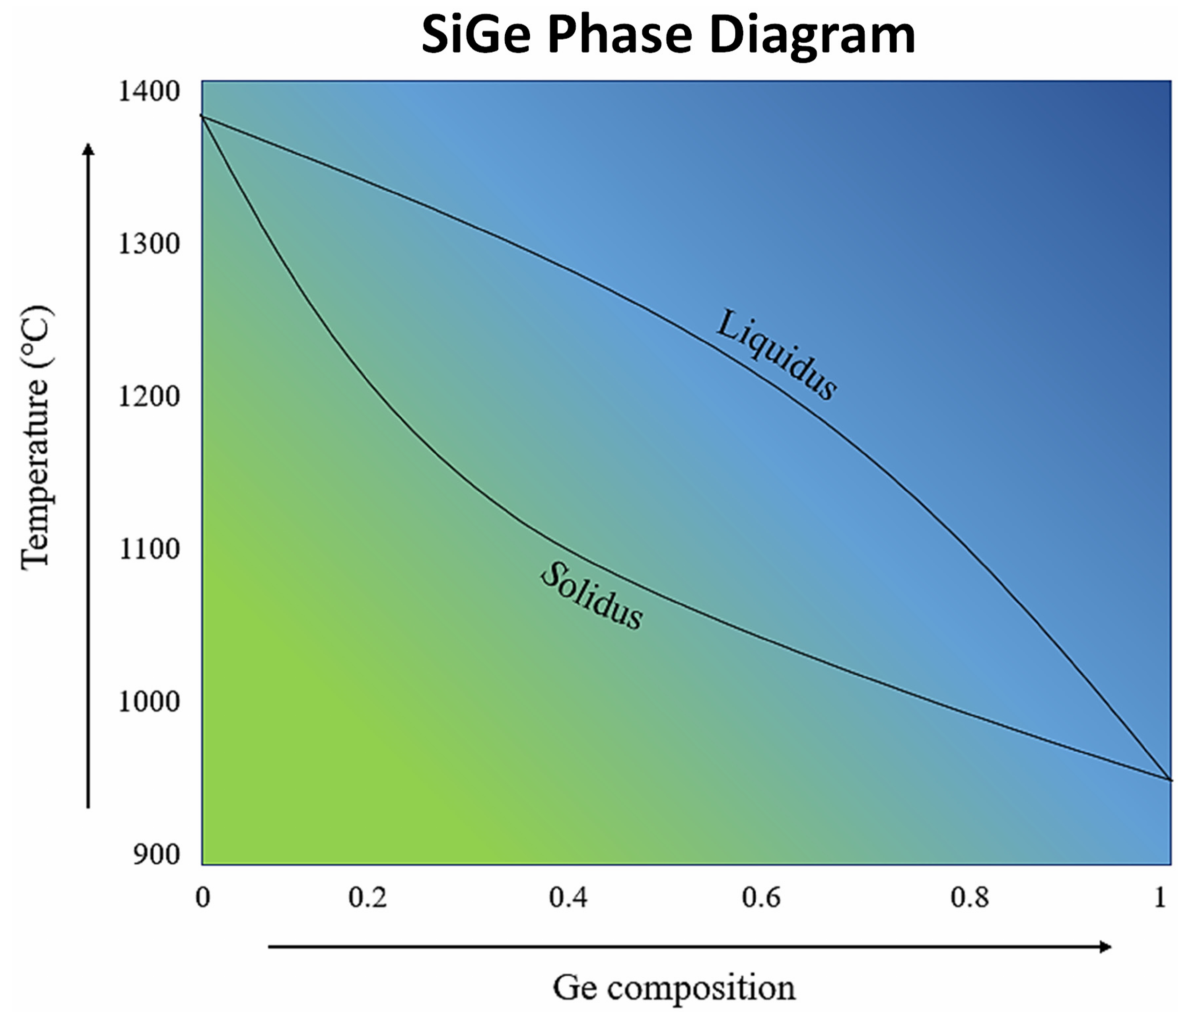
Figure 6. Phase diagram of SiGe. Figure reproduced with permission from “Towards a Fully Functional Integrated Photonic–Electronic Platform via a Single SiGe Growth Step” from Littlejohns et al., 2016